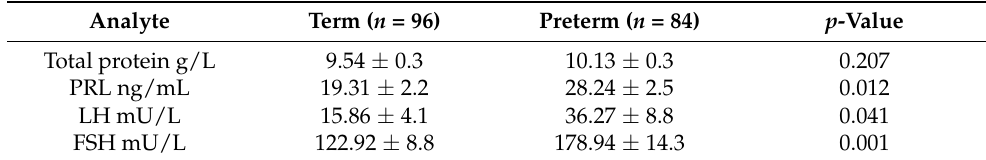
Table 2. Total protein, prolactin (PRl), luteinizing hormone (LH), and follicle-stimulating hormone (FSH) concentration in term and preterm milk during the first 6 months of lactation. Analyte Term ( n = 96)